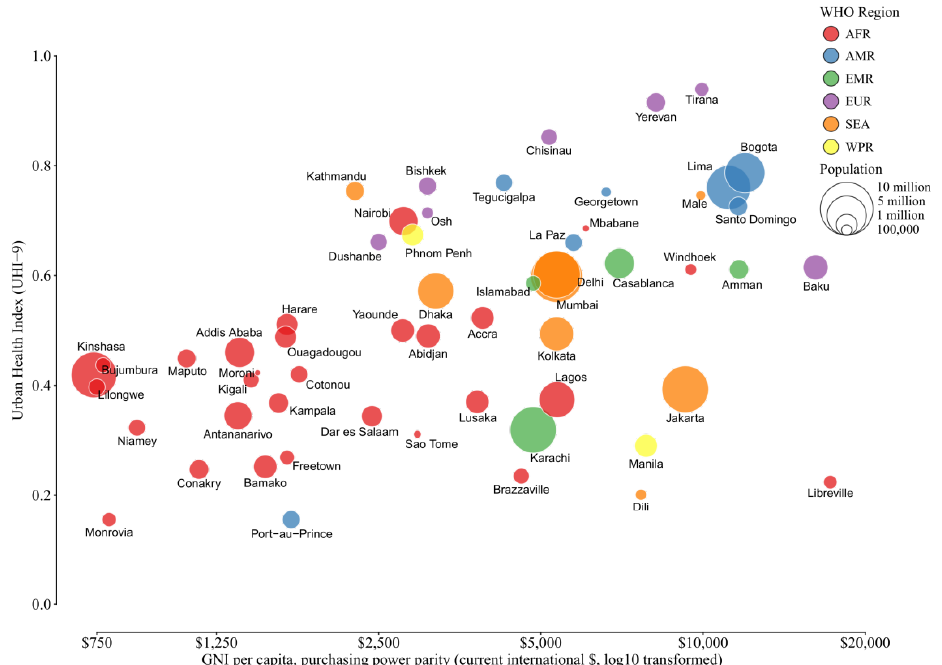
Figure 3. Relationship of UHI-9 and country-level per capita gross national income. The graph contains four variables: the raw UHI-9 score for the city, the log 10 transformed per capita GNI, population size (represented by the size of the bubble), and World Health Organization (WHO) region (depicted by color).